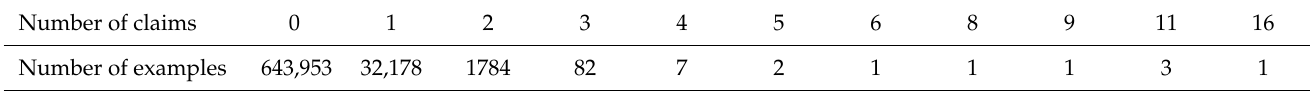
Table 2. Number of examples with a given number of